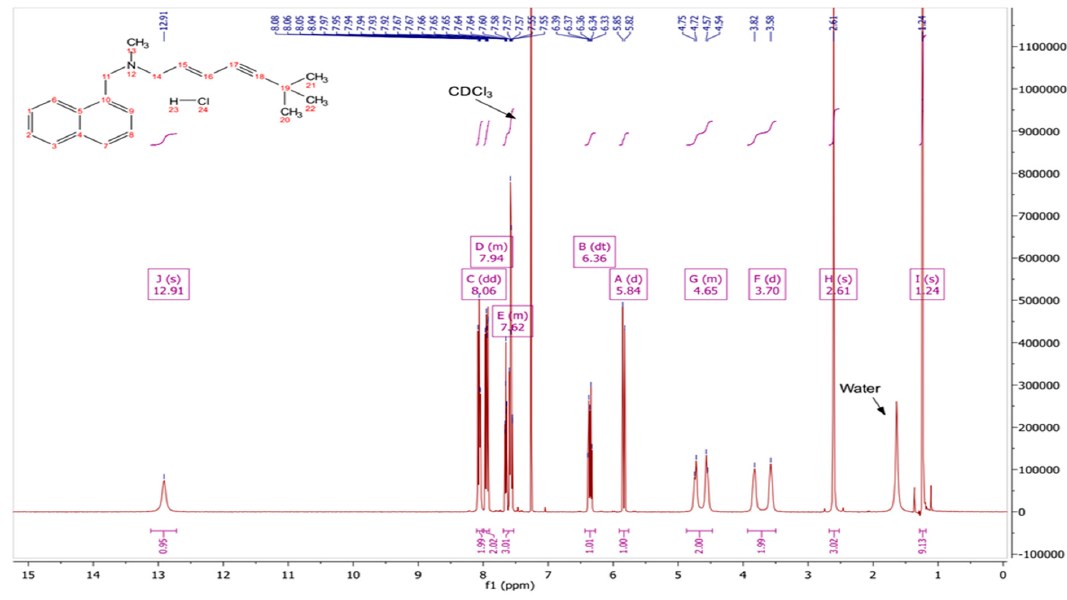
Figure 2. 1 H NMR spectrum of TBF HCl.